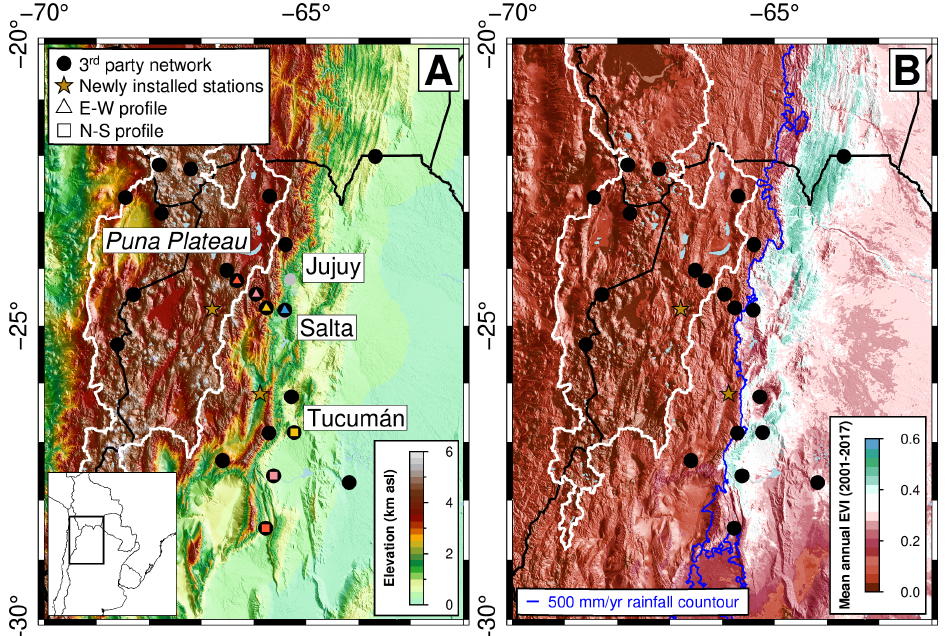
Figure 1. Topographic setting of the south-central Andes with GNSS station network location. We have selected a subset of these stations for an analysis of water vapour transport: across the Andes in east–west (E-W) direction (UNSA, GOLG, SRSA, and SALC) and along the Andes in north–south (N- S) direction (UNSA, TUCU, JBAL, and CATA). UNSA, GOLG/TUCU, SRSA/JBAL, and SALC/CATA are represented with blue, yellow, pink, and orange colours, respectively. The white line outlines the internally drained Altiplano–Puna plateau, also called the Central Andean plateau. Black lines are international borders ( A ). ( B ) shows enhanced vegetation index (EVI) information for the area of interest between 2001 and 2017. The blue line points out 500 mm annual rainfall (Topographic data obtained from ETOPO1 [18], EVI data obtained from MODIS/Terra [19], rainfall information retrieved from the Tropical Rainfall Measuring Mission (TRMM) [20], as cited in Bookhagen and Strecker